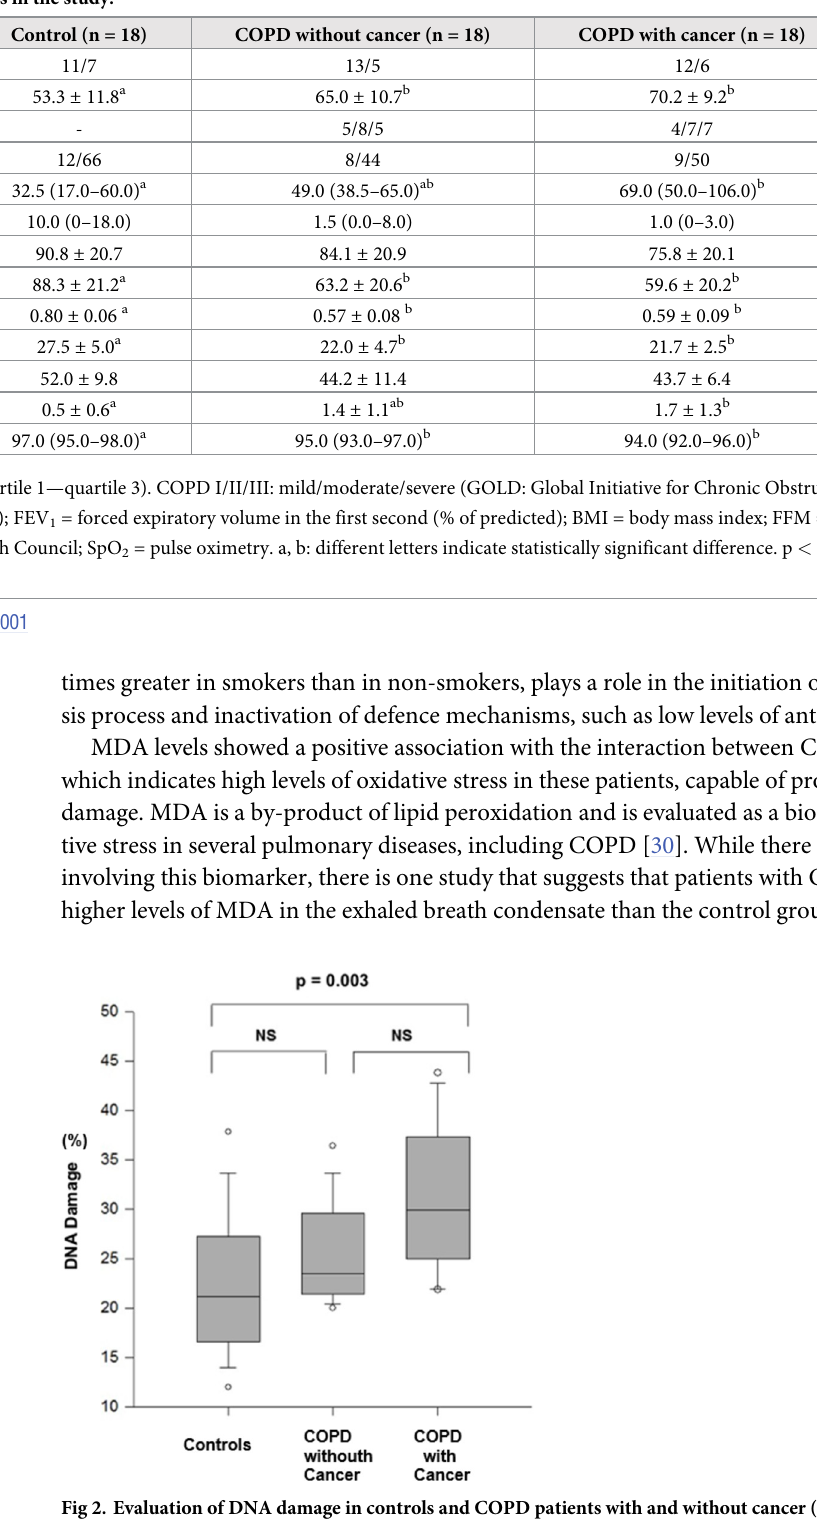
Fig 2. Evaluation of DNA damage in controls and COPD patients with and without cancer (Kruskal-Wallis and Dunn’s test). NS: